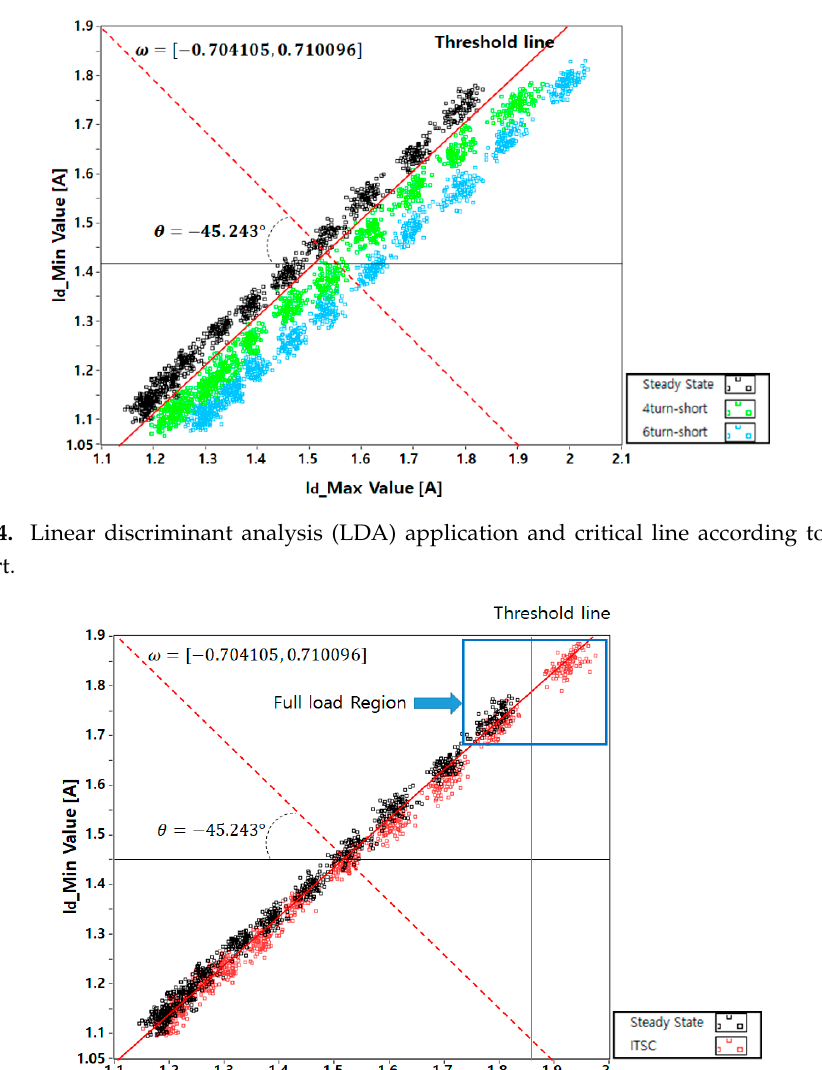
Figure 13. D-Q min–max coordinate system according to the speed change.